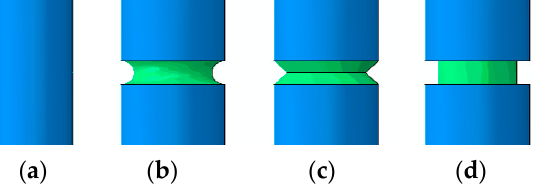
Figure 5. Bolt models of four structures. ( a ) Non-notch; ( b ) arc-shaped; ( c ) V-shaped; ( d ) square notch.